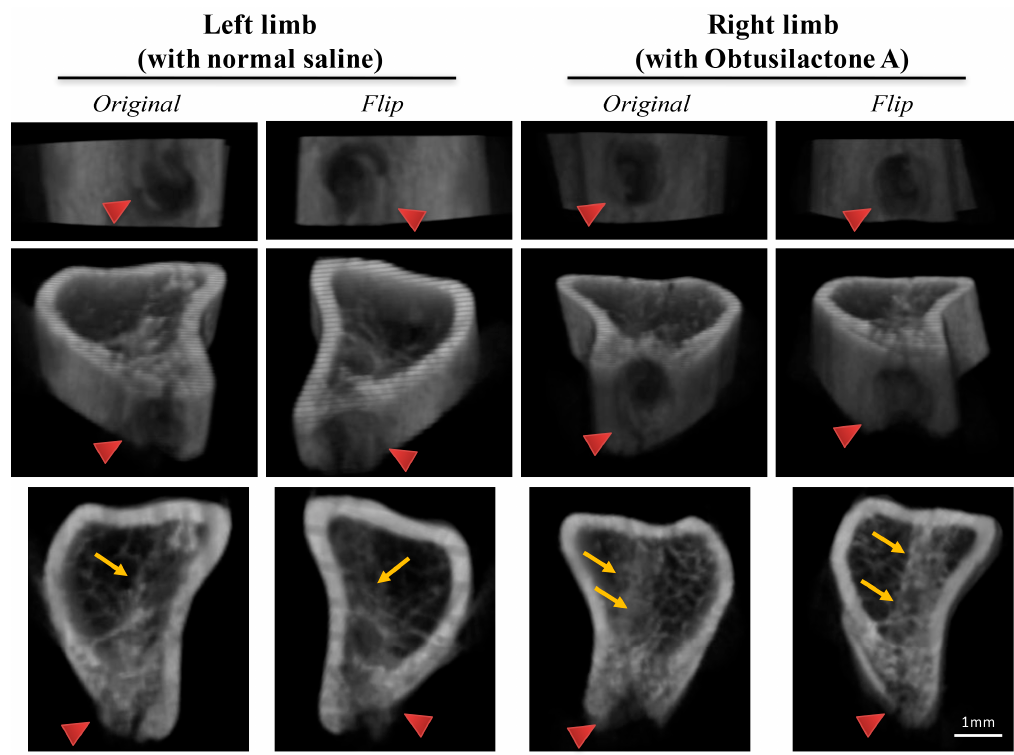
Figure 5. 3D reconstructed micro-CT images show enhanced trabecula bone formation in OA-treated rat tibias. The original and flip 3D micro-CT images around the ROI of the tibia (4-mm radius around 1.0-mm up and down from the region of the needle implantation site; 100 cuts) in OA-treated right tibias (right panel) and normal saline-treated left tibias (left panel) of rats after 14 days of administration (red arrow head: the needle implantation site; yellow arrow: the new-formed trabeculae).